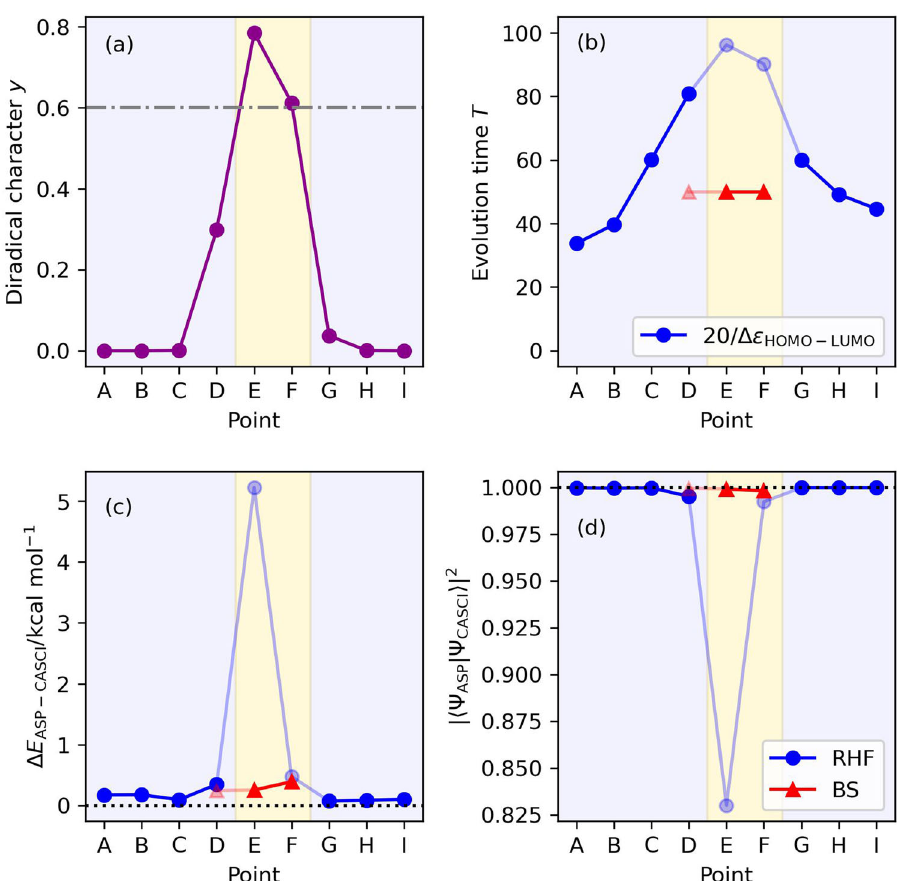
Fig. 10 Results of the numerical simulation of ASP of the C 2 v quasi-reaction pathway of Be + H 2 → BeH 2 , using the diradical character as the indicator for selecting the initial wave function. Background colors specify the regions of the initial wave function recommended from the criterion based on the diradical character y > 0.6. Sinusoidal and square functions were adopted as the scheduling functions with the | Ψ HF 〉 and | Ψ BS 〉 , respectively, as the starting wave function. a Diradical characters calculated using Eq. 6. b Evolution time lengths. c The energy differences from the CASCI values. d The square overlaps with the CASCI wave